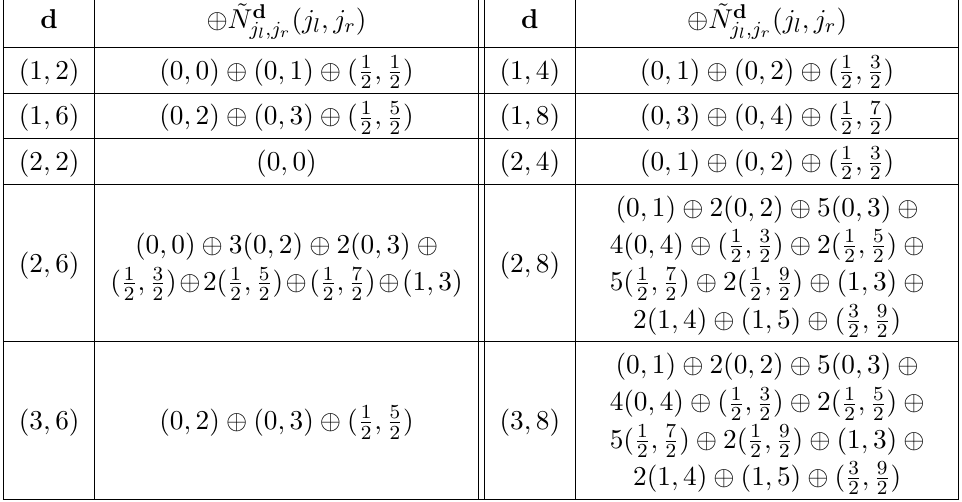
Table 3 . Spectrum of the adjoint Wilson loop operator in the SU(2) 0 theory for d 1 ≤ 3 and d 2 ≤ 8 . For the SU(2) theory, we use magnetic fluxes as n ∈ Z , B 0 equations. The result at k = 1